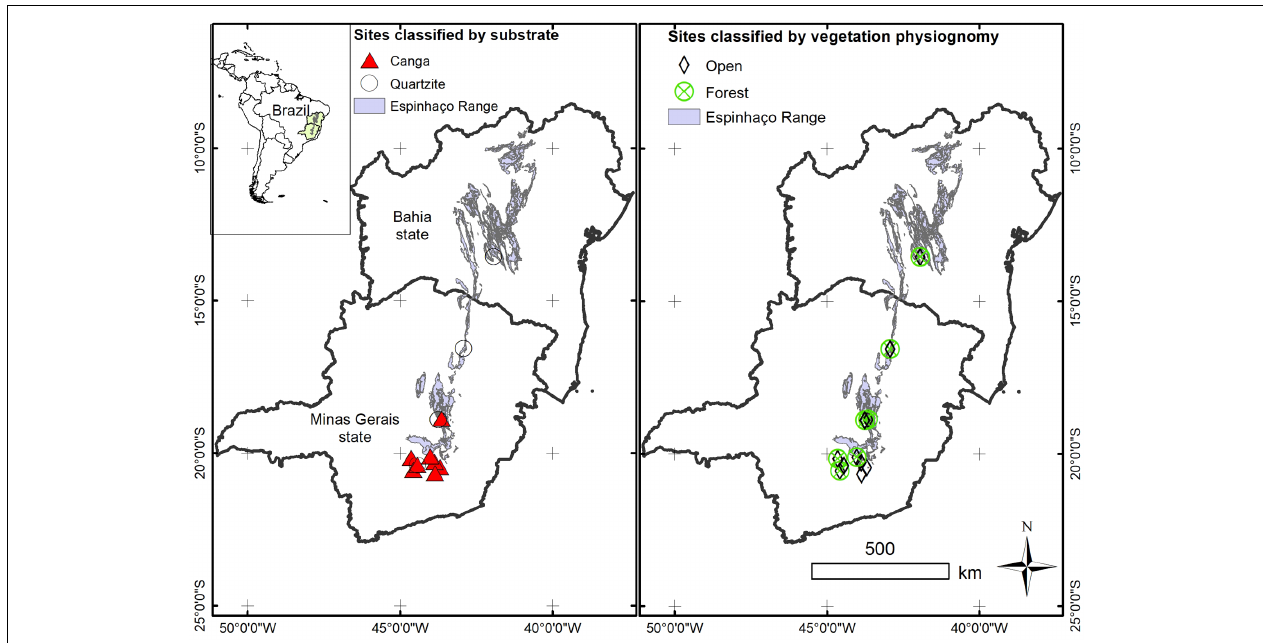
FIGURE 2 | Map showing the geographical location of the sites included in our analysis. Each site is classified according to the substrate and physiognomy of the